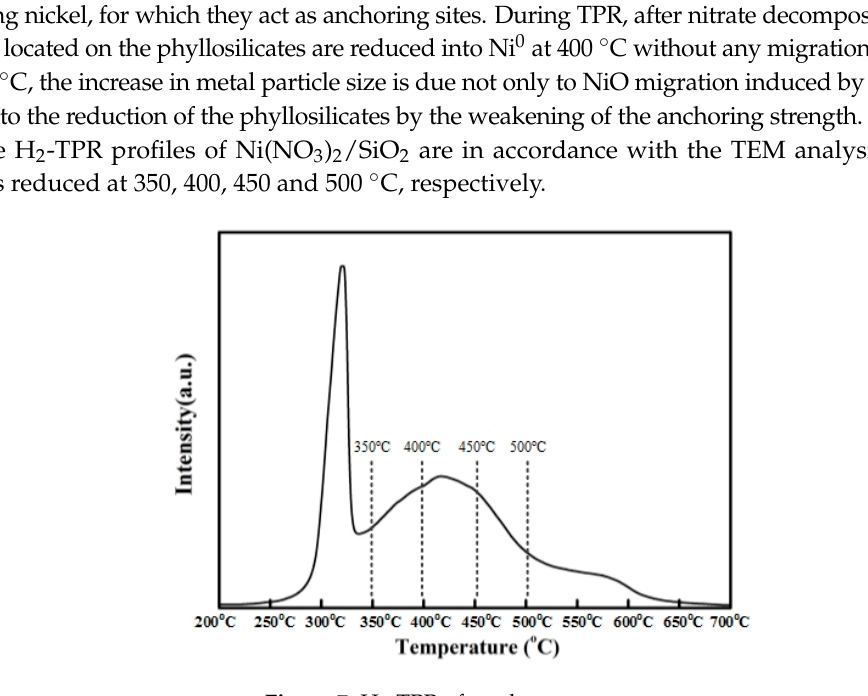
Figure 7. H 2 -TPR of catalyst precursors.